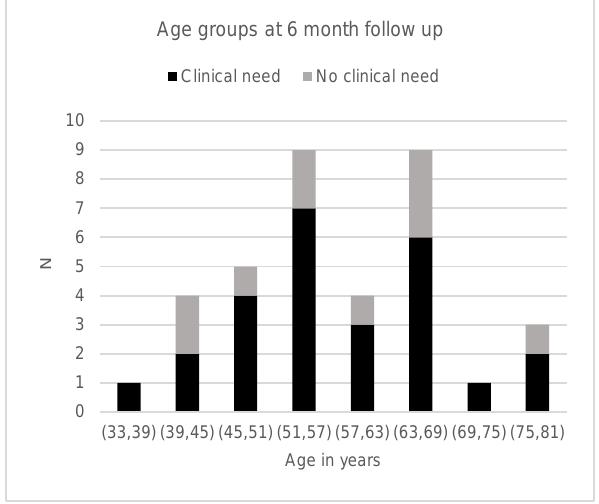
Figure 2: Age groups at 6MFU divided into "clinical need" (N=26) and "no clinical need"